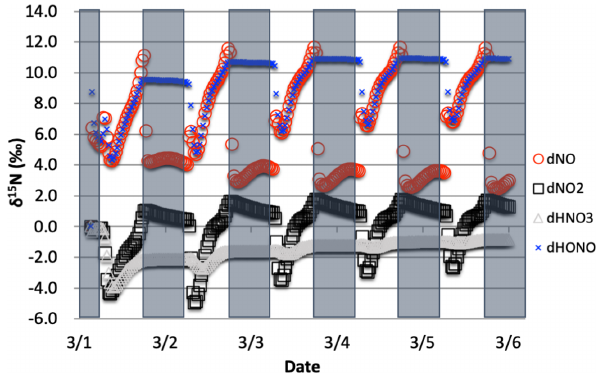
Figure 8. The δ 15 N values of NO x , HONO, and HNO 3 when iso- tope effects associated Reactions (R1) and (R48) are combined, with NO x emission. The 5d simulation was under the conditions list in Table S3a and b. The diurnal patterns are reflecting the rela- tive importance of photolysis and O 3 chemistry during the day and